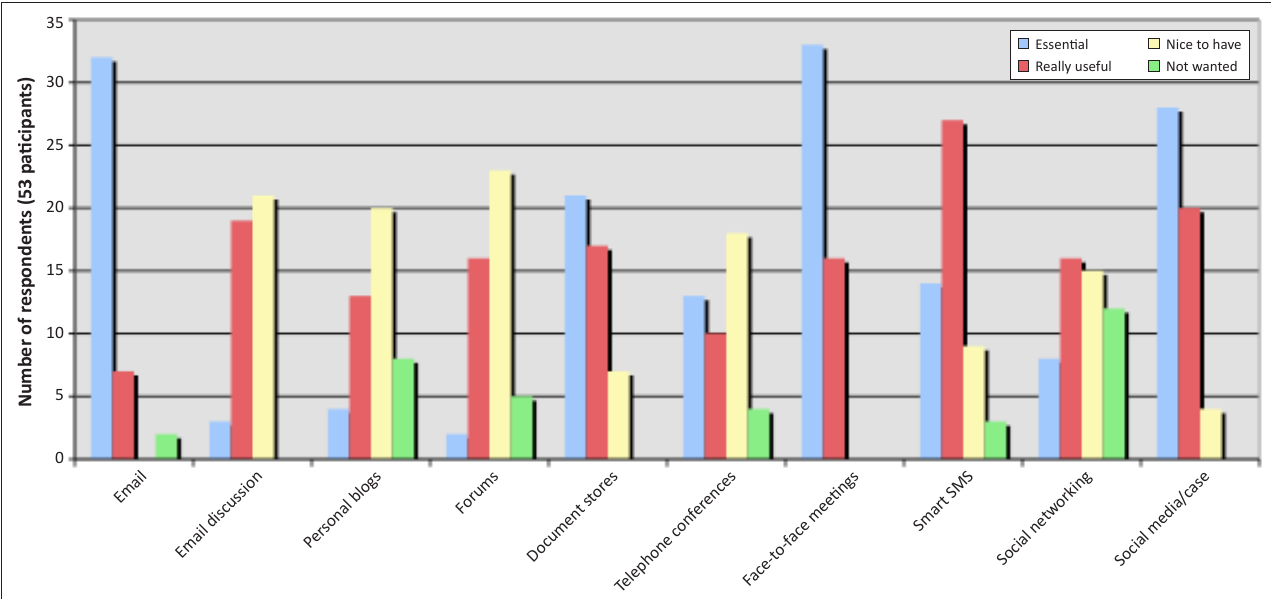
FIGURE 2 : Assessment of different communication methods. Live poll at Global Workshop January